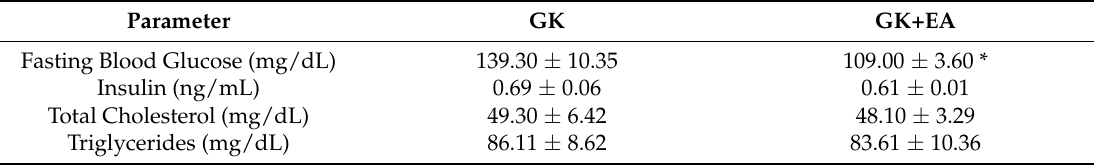
Table 2. Glucose and lipid parameters of diabetic female GK rats after oral treatment with Ellagic Acid (EA) (50 mg/kg) for 45 days. ( n = 6 per group)